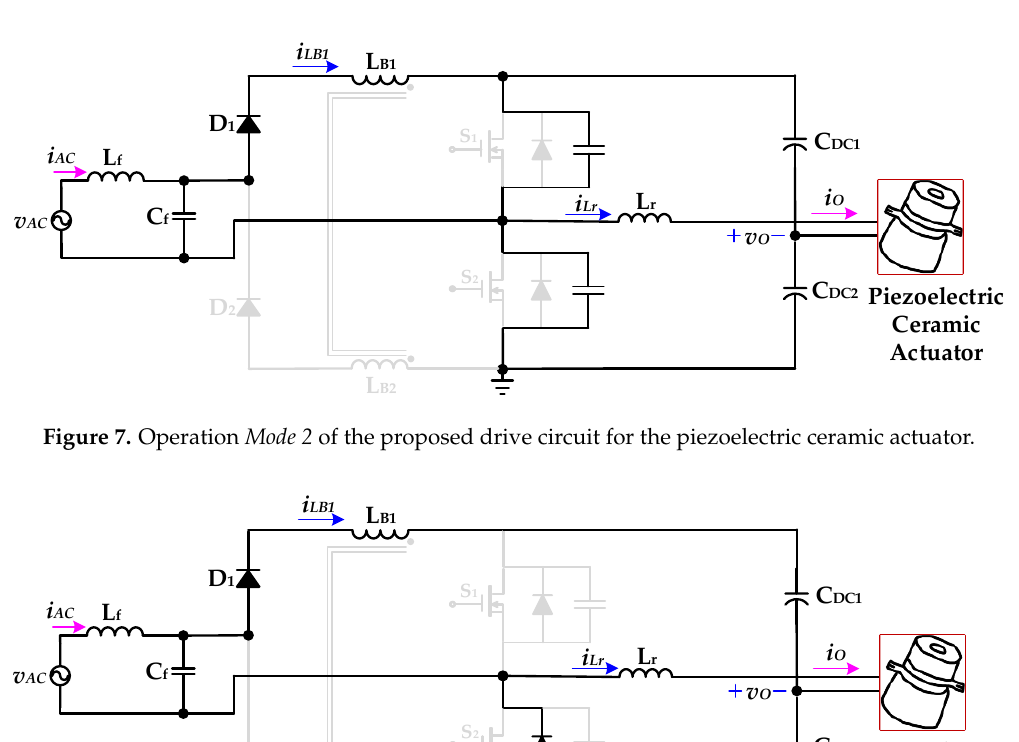
Figure 7. Operation Mode 2 of the proposed drive circuit for the piezoelectric ceramic actuator. Figure 8. Operation Mode 3 of the proposed drive circuit for the piezoelectric ceramic actuator.